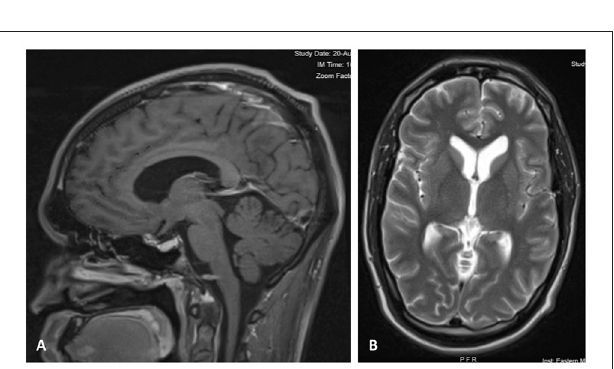
FIGURE 2 | (A) Contrast-enhanced Sagittal T1 image 6 months after craniotomy, showing decompression of the sellar region with resolved mass effect over the optic pathway. (B) Axial T2 MRI at 6 months after surgery, showing normal size of ventricles and sulci.